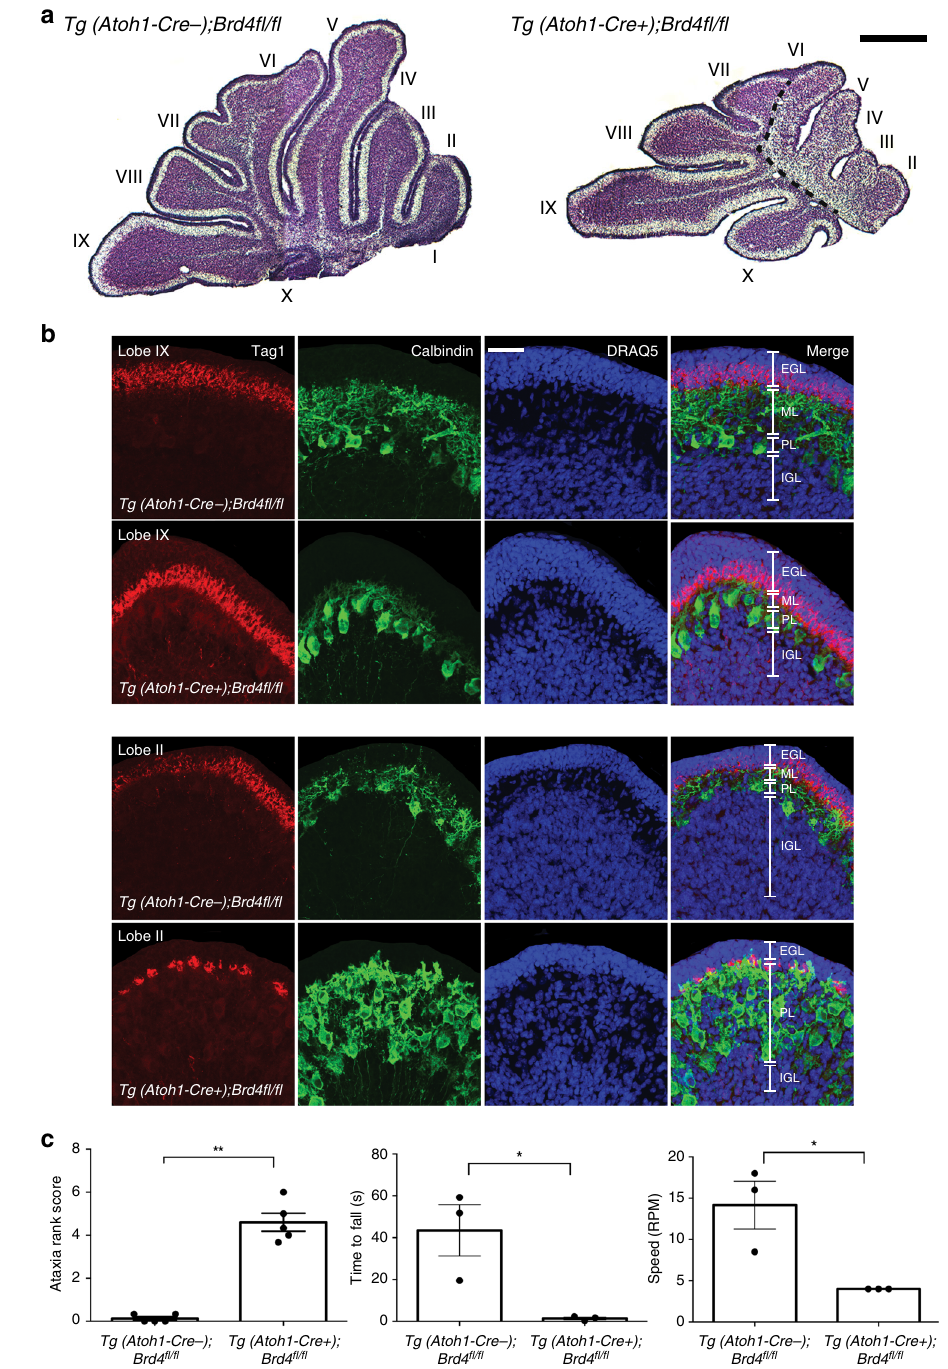
Fig. 6 Conditional deletion of Brd4 in the developing cerebellum induces cerebellar de fi cits and ataxia. Tg ( Atoh1-Cre + );Brd4 fl / fl mice have disrupted cerebellar morphology relative to Tg ( Atoh1-Cre-);Brd4 fl / fl mice. Representative images are from P8 cerebellum mid-sagittal sections of approximately the same location in vermis. a Cresyl violet stain shows reduced cerebellum size in Tg ( Atoh1-Cre + );Brd4 fl / fl mice versus Tg ( Atoh1-Cre);Brd4 fl / fl mice. Cerebellar lobes are indicated I – X. Dotted line in Tg ( Atoh1-Cre + );Brd4 fl / fl divides the anterior and poster cerebellum to emphasize changes to proliferation and structure and proliferation, respectively, in each region. Scale = 500 µ m. b Brd4 loss in GCPs disrupts Purkinje cell development. Confocal images are from the posterior lobe IX and anterior lobe II. Tag1 is a marker for migrating GCPs, Calbindin is a marker for Purkinje cells, and DRAQ5 is a DNA marker. Scale = 50 µ M. EGL = external granule layer, ML = molecular layer, PL = Purkinje cell layer, IGL = internal granule layer. c Tg ( Atoh1-Cre + );Brd4 fl / fl mice exhibit symptoms of cerebellar ataxia. Adult ( ≥ P28) Tg ( Atoh1-Cre + );Brd4 fl / fl mice or Tg ( Atoh1-Cre + );Brd4 fl / fl mice were assessed for ataxia symptoms using multiple rank composite tests. Scores from each test were pooled with higher scores indicating symptom severity. Rotarod testing was performed, and latency to fall and speed at fall were recorded for each group after 5 days of training. The results are the average of three independent experiments, and are represented as the mean ± SEM. For ataxia, rank scores a Mann – Whitney U test and for rotarod testing an unpaired t test were performed (* p < 0.05, ** p < 0.01). Source data can be found in source data graphs under tab for Fig.